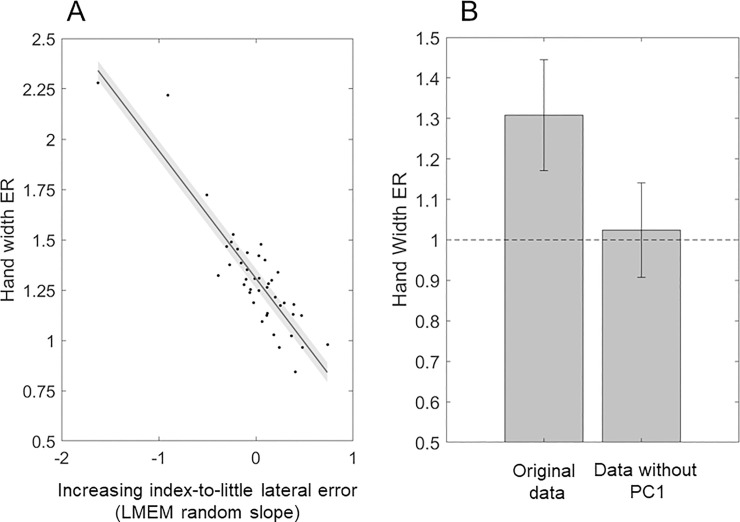
(A) The slopes obtained from the Linear Mixed-Effects Model (LMEM) exploring the effect of the knuckle (coded as a continuous variable, 1 to 4) on the medio-lateral errors, which strongly predicts the hand width estimation ratio (hand width ER: perceived / actual hand width). The shaded area represents the slope’s standard error of the mean. (B) The hand width ER calculated on the original data is higher than the hand width ER calculated on the same data after removing the PC1 (first principal component) extracted by performing the PCA on the medio-lateral errors.